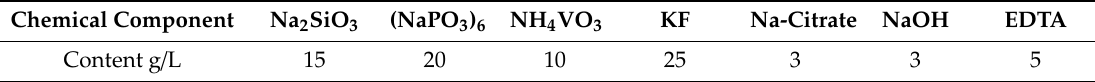
Table 3. Composition of electrolyte.